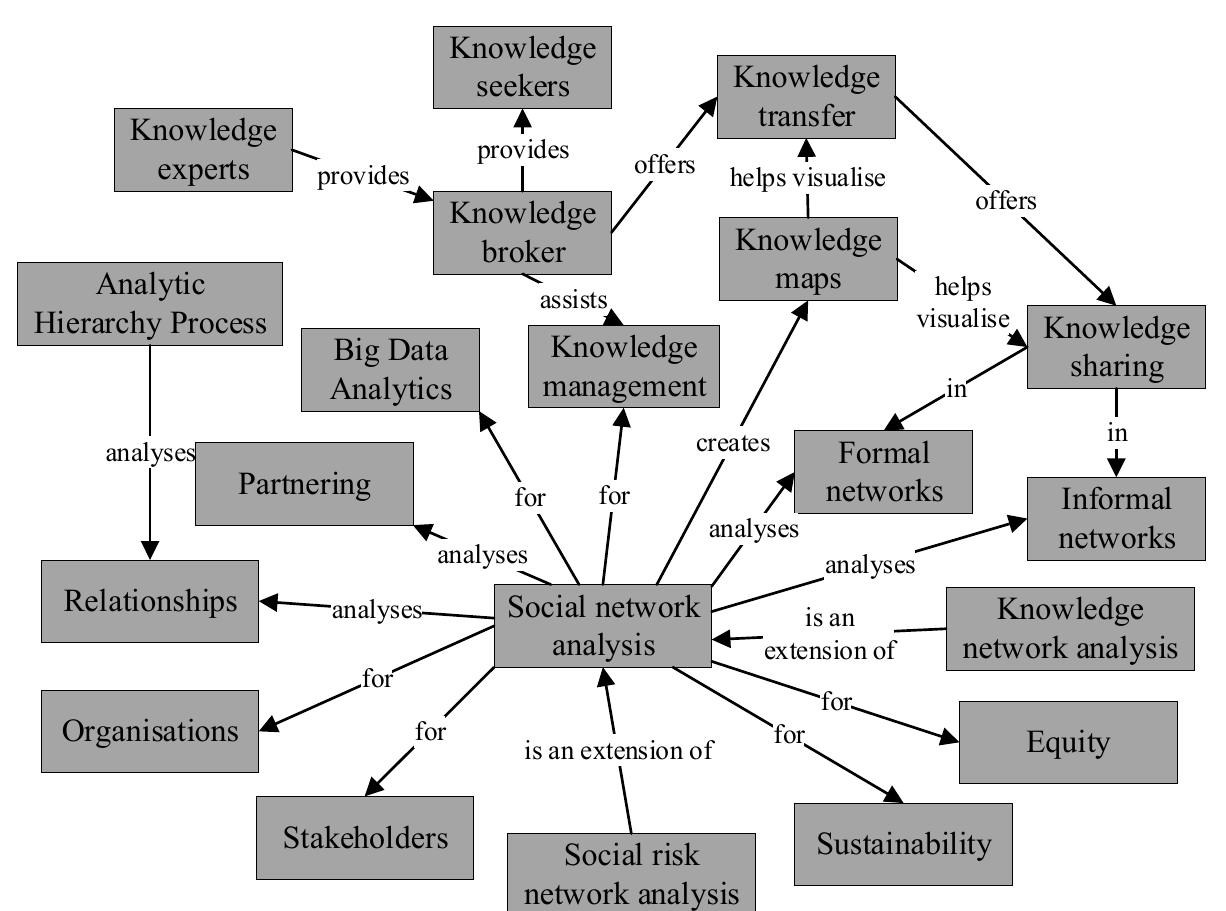
Figure 4. Concept map on trends and extensions of SNA for KM.